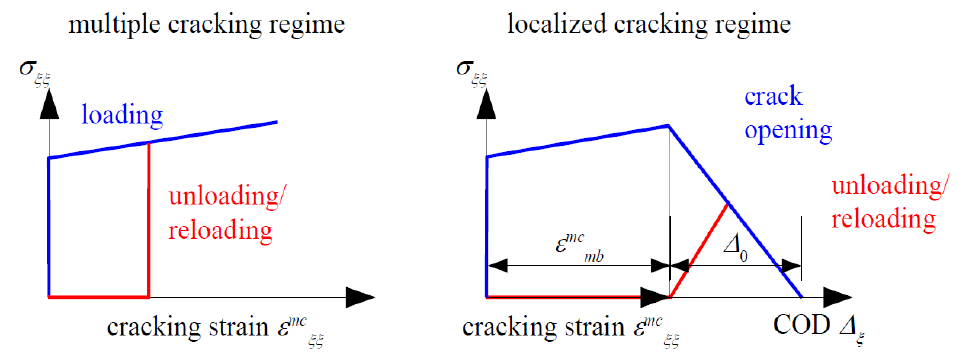
Figure 3. Stress vs. cracking strain relations in crack-normal direction [54].